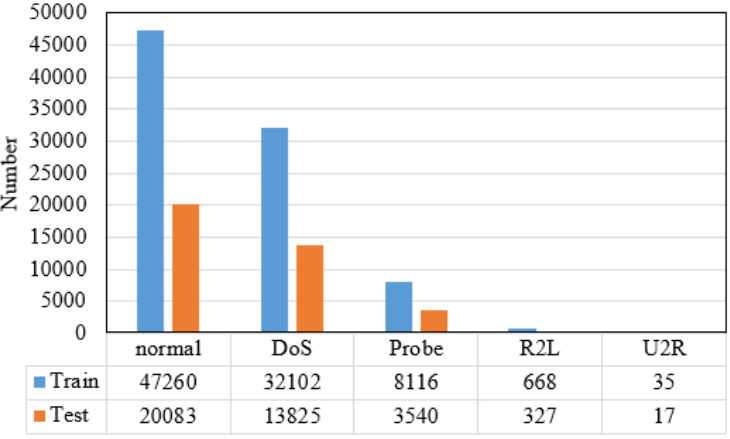
Figure 7. The number of samples of each category in the experimental dataset.